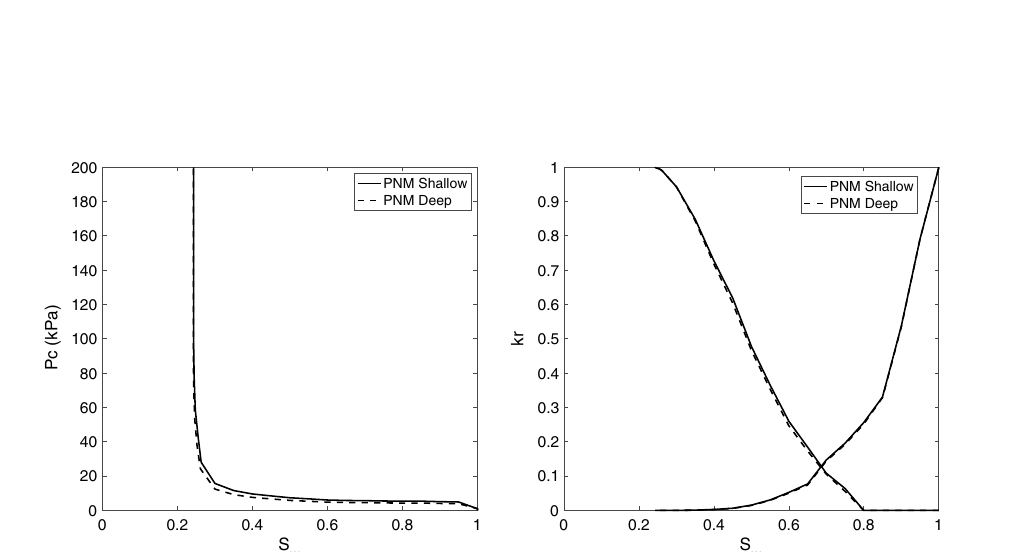
Figure 4. Capillary pressure (left) and relative permeabilities (right) for the base case, i.e., for Berea sandstone using the experimentally-relevant fluid properties of θ a = 85 case corresponds to the Shallow formation of Table 2. Also shown are the results corresponding to the fluid properties of the Deep